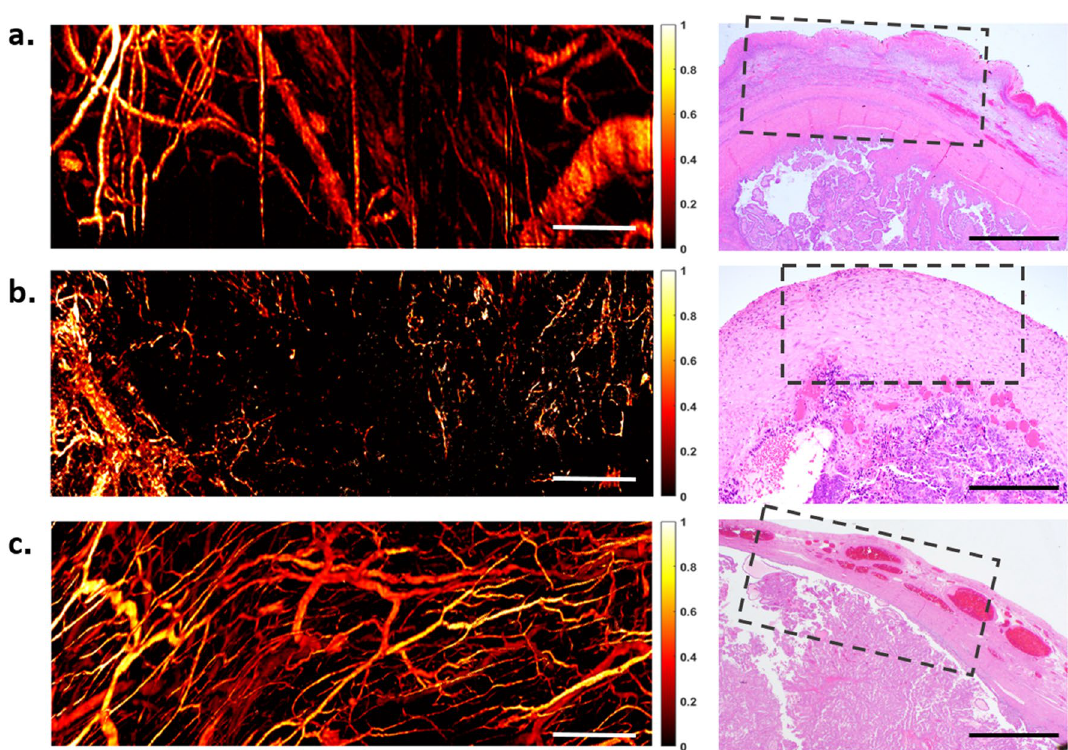
Figure 6. Representative images of ovarian lesions and fallopian tubes with various degrees of malignancies. ( a ) Ovary with borderline tumor, ( b ) ovary with endometroid carcinoma, and ( c ) fallopian tube with metastatic high-grade carcinoma of endometrial origin. Scale bar: 500